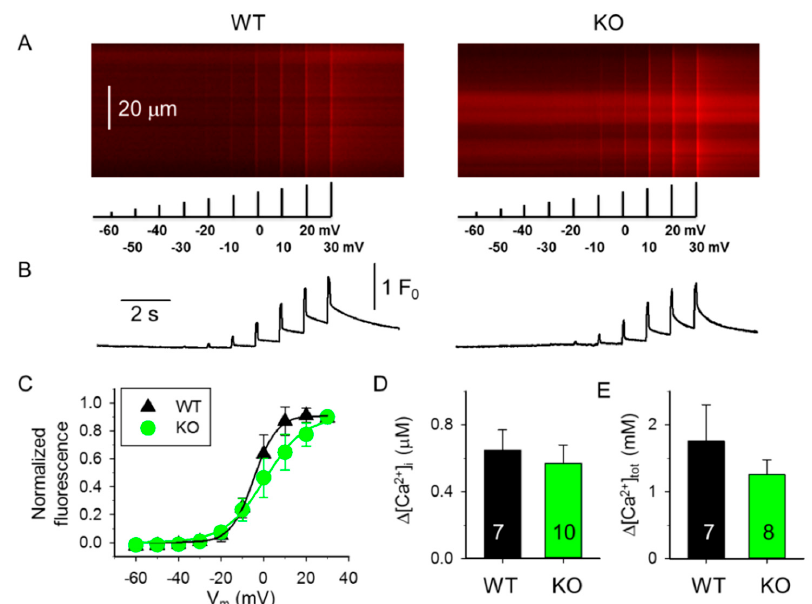
Figure 3. Membrane potential dependence of changes in [Ca 2+ ] i in 10-month-old WT and sAnk1 KO mice. ( A ) Line-scan images of changes in [Ca 2+ ] i elicited by the same depolarization protocol as in Figure 2. The scale bar in the left panel corresponds to both line-scans. ( B ) Temporal profile of the changes in [Ca 2+ ] i calculated from the corresponding images in panel A. ( C ) Voltage dependence of the changes in [Ca 2+ ] i . Values were obtained as described for Figure 2C. Continuous lines represent the best fit of the Boltzmann function to the average values with parameters of k = 8.09 and 14.67 mV, and V 50 = − 5.94 and − 7.86 mV, for WT ( n = 9) and KO ( n = 9), respectively. ( D , E ) Pooled data for Δ [Ca 2+ ] i ( D ) and amount of Ca 2+ released ( E ) at +30 mV depolarization for three WT and five KO mice. To assess the peak change in [Ca 2+ ] i ( D ) and the amount of Ca 2+ released ( E ), 100 ms and 1 s long single pulses were used, respectively. Numbers in columns show the number of fibers averaged.